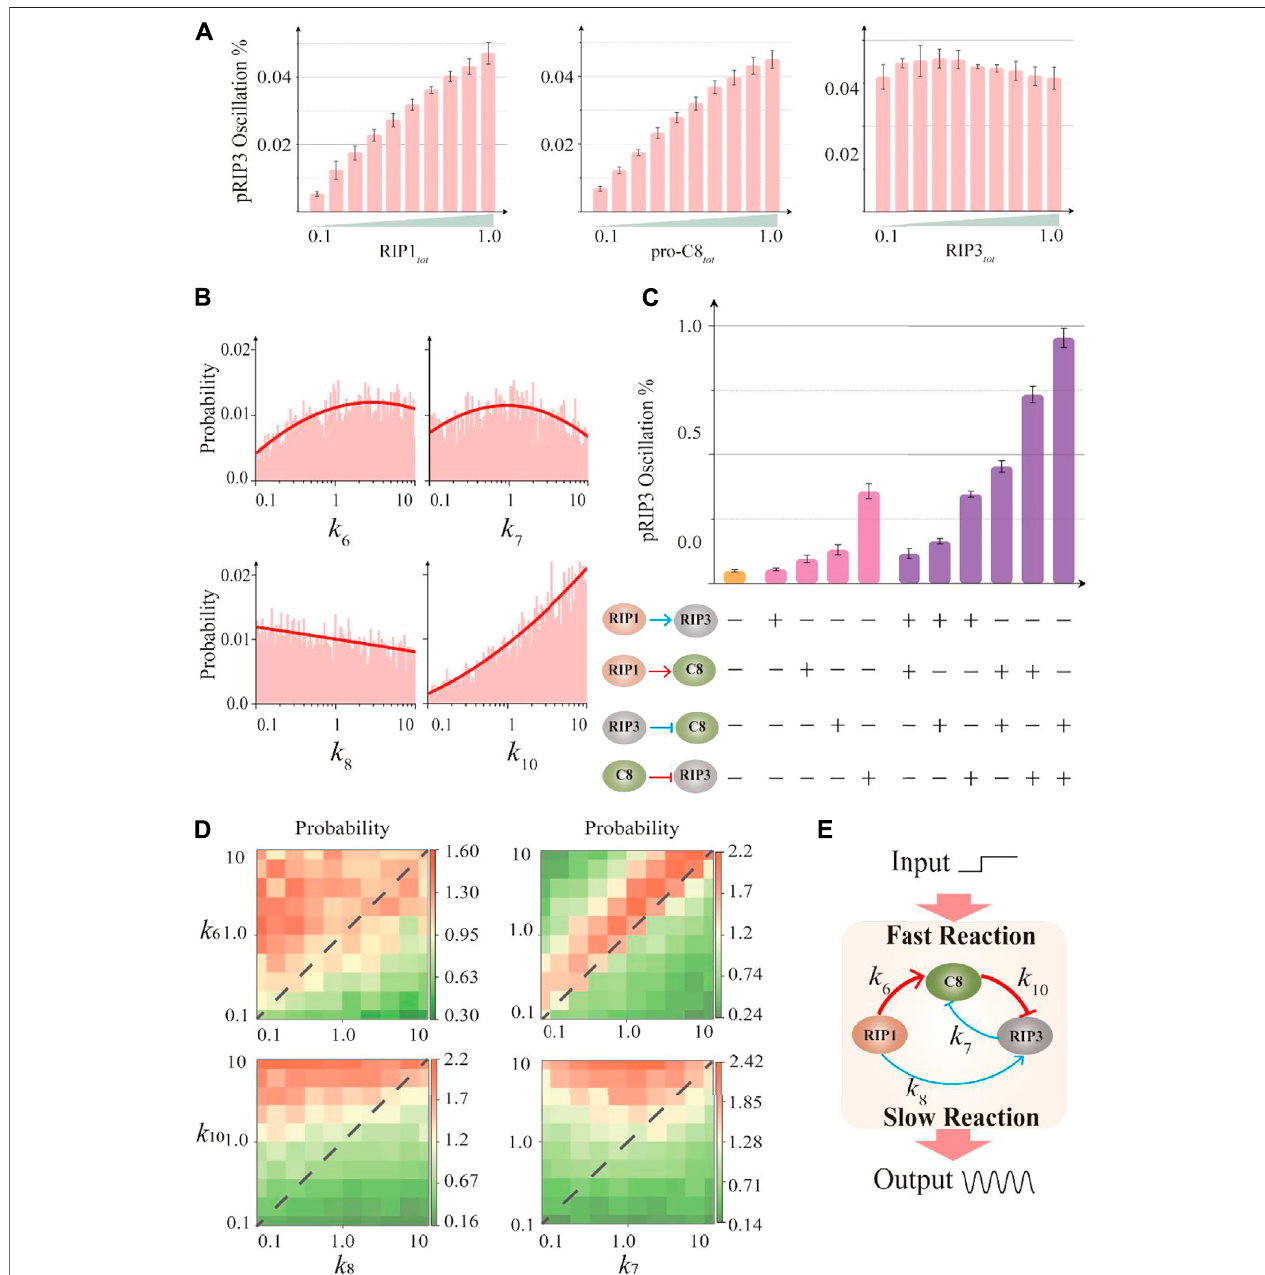
FIGURE 3 | Effects of the components within the essential structure on the circuit oscillation probability. (A) Effects of the three key proteins total amount on the oscillation probability. (B) The parameter distributions with stable oscillation of the four parameters in the essential structure. (C) The probability of RIP3 oscillation is substantially improved when two interaction terms are constrained during the random parameter search. The “ + ” indicates that the term is constrained, and the “ − ” indicatesthatthetermisunconstrained. (D) Theheatmapsthatre fl ectthevariationofprobabilitywhentwo-parametersarechanged. (E) Schematicdiagramofthe fast and slow dynamics within the essential structure. Thick red lines indicate fast dynamics and thin blue lines indicate slow dynamics.